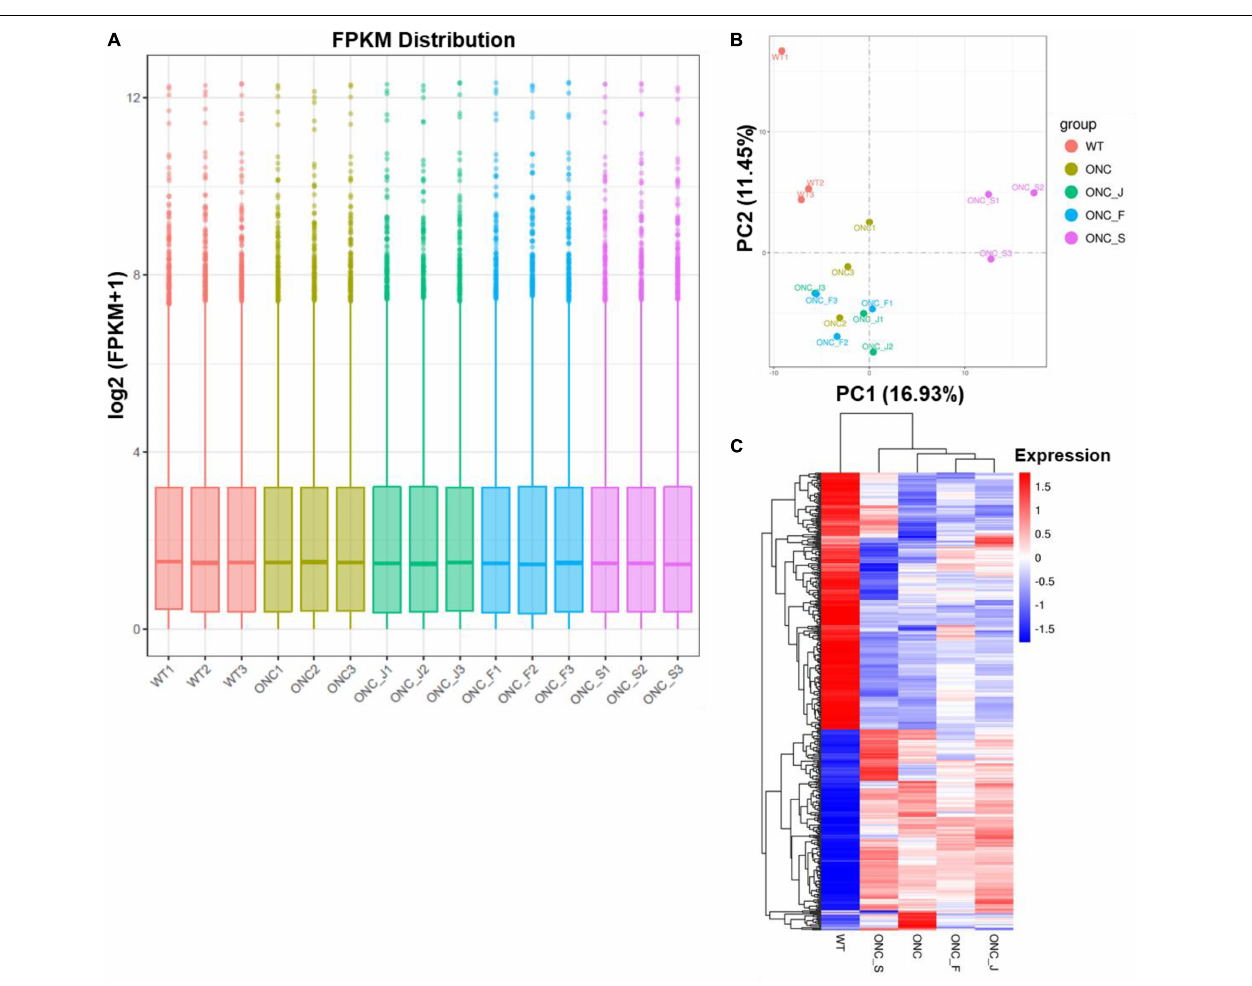
Frontiers in Integrative Neuroscience |